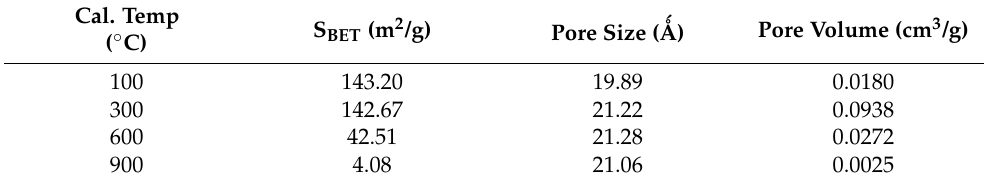
Table 1. Surface area, pore size, and volume of SnO 2 NPs.